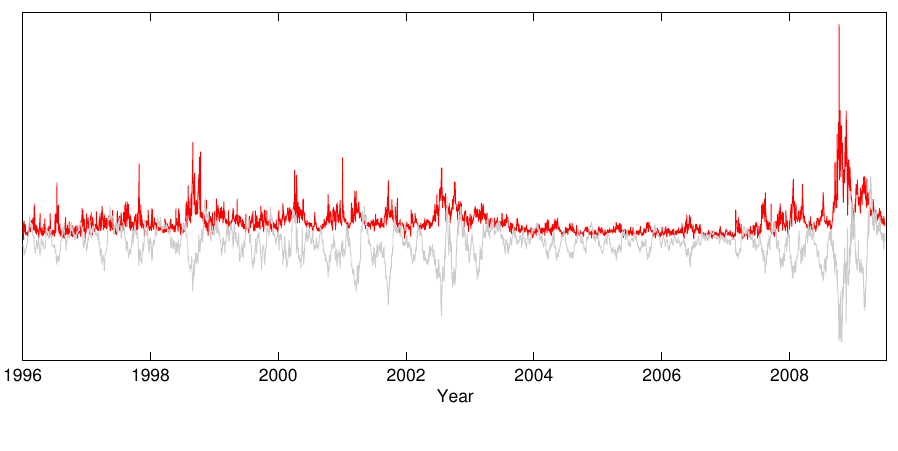
Figure 7. Realized volatility ( top ) and monthly returns ( bottom ) for the S&P 500